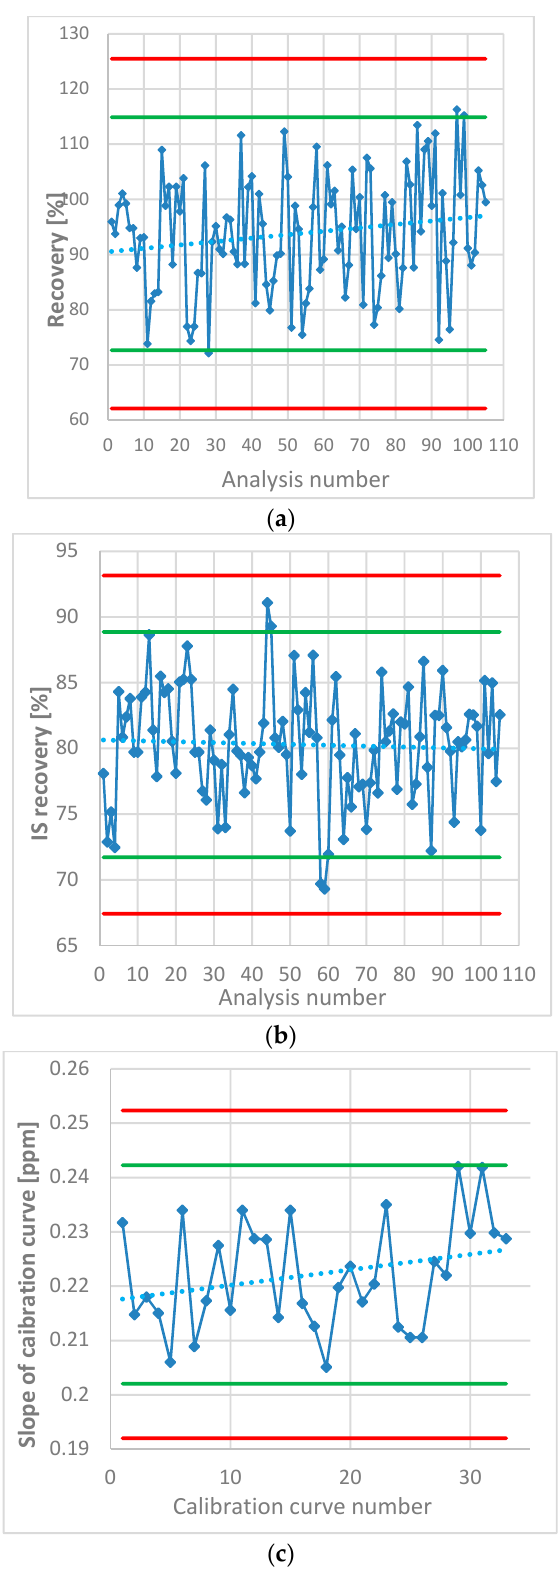
Figure 2. ( a ) NDMA recovery in the spiked samples estimated in each analysis of the metformin products. ( b ) Internal standard (IS – d 6 -NDMA) recovery as a percentage of the mean peak area in the standard solutions. ( c ) Slope of the calibration curves of NDMA calculated in each analysis. Green lines represent ± 2 × SD, red lines represent ±3 × SD.